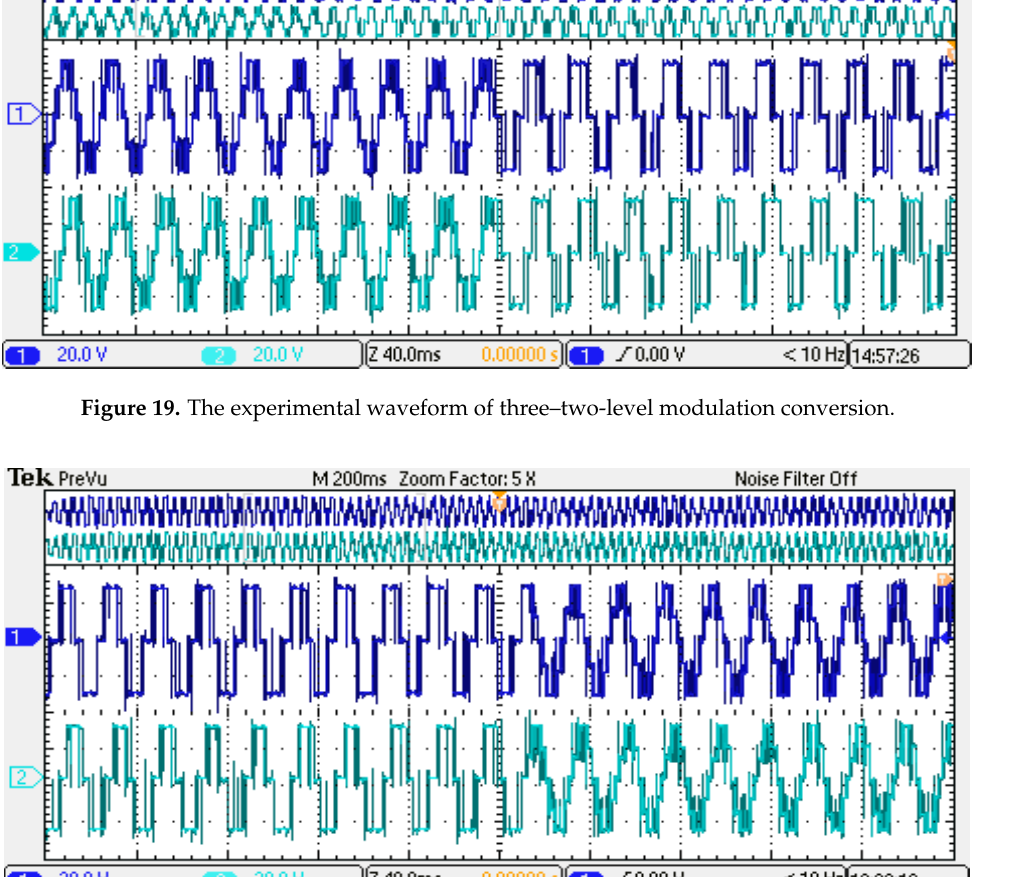
Figure 20. The experimental waveform of two–three-level modulation conversion.